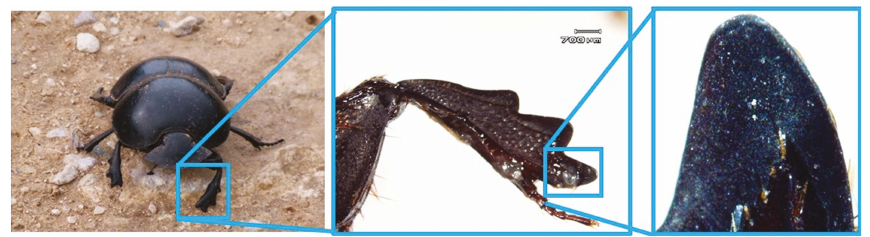
Figure 3: End-tooth on the foreleg of the dung beetle ( Copris ochus Motschulsky).